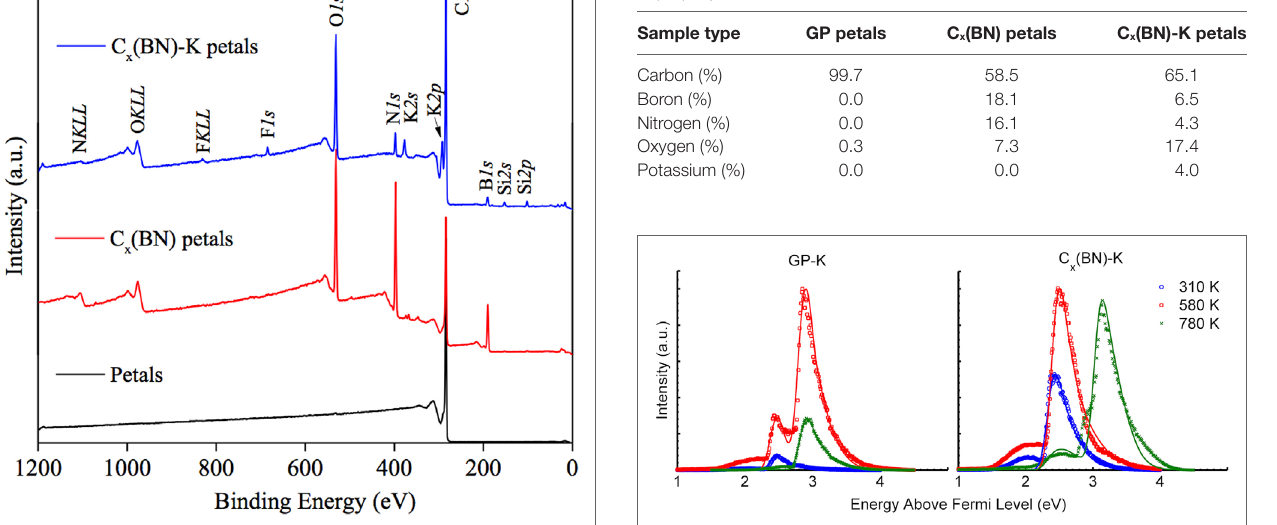
FigUre 7 | Photoemission electron energy distributions recorded at 310, 580, and 780 K during the second heating cycle of AM1.5 solar simulator illuminated potassium-intercalated GP-K petal and C x (BN)-K petal samples. Corresponding fits from theory are also plotted.